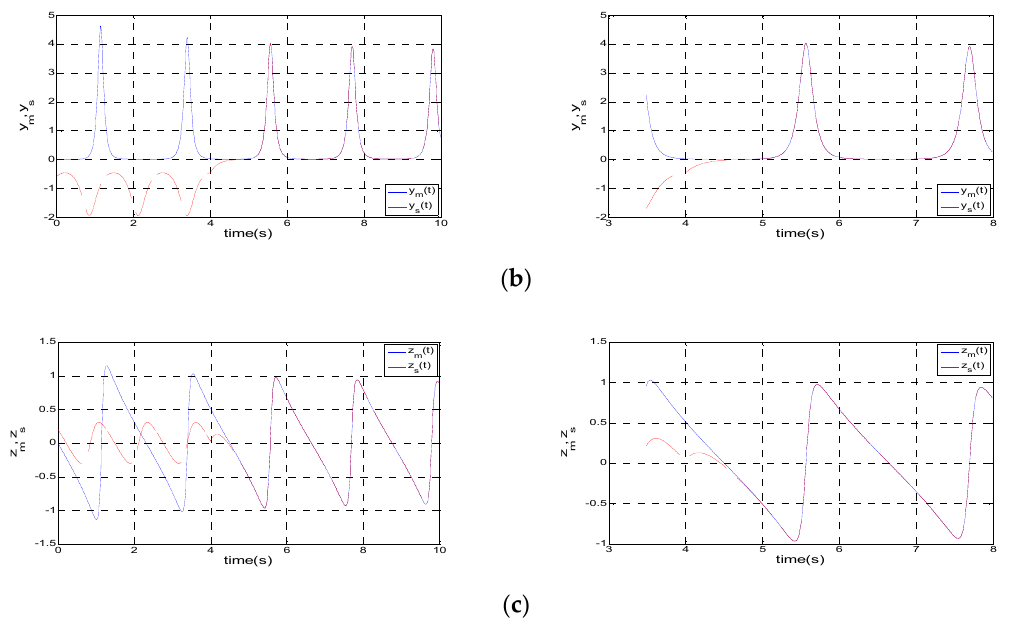
Figure 3. Synchronization process between master-slave systems by numerical simulation; ( a )